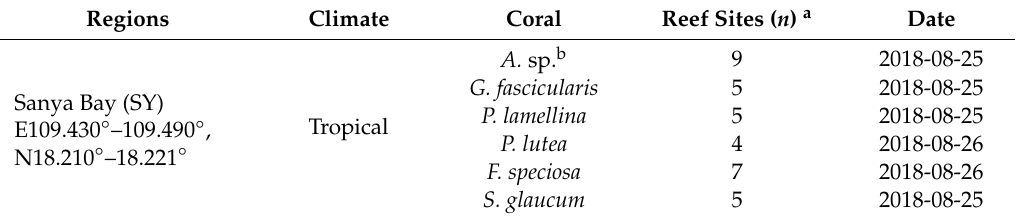
Table 1. Coral samples from tropical and subtropical reefs of the South China Sea (SCS). Including sampling regions (latitudes and longitudes), climate, coral samples information. Regions